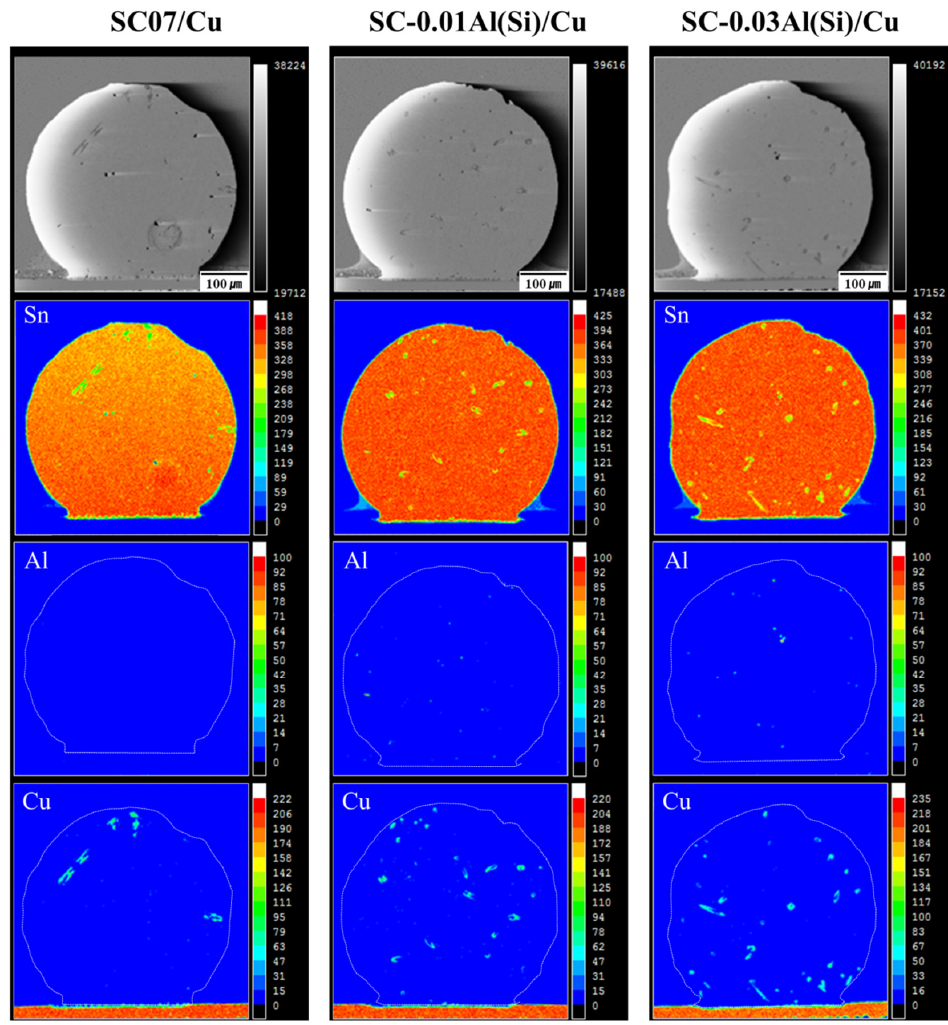
Figure 10. EPMA electron mapping of various solder joints after 10 reflows [27]. Thermodynamic calculations and experiments have shown that the ternary Sn-Al- Cu system has a large stable liquid miscibility gap [36,37], through which Al-Cu IMCs should traverse through Al-added solder alloys during soldering. According to a report by Kotadia et al., when Al was added to the SAC305 solder, Al 2 Cu IMCs were observed after the reflow [38]. Figure 11 shows the TEM image of the SC-0.03Al(Si) solder and the selected area electron diffraction (SAED) patterns after 10 reflows. In Figure 11b,c, Al-Cu IMCs and Cu-Al-Sn IMCs were observed. The SAED patterns are consistent with the re- ported crystal structures of Al 2 Cu IMCs and Cu 3 (Al 0.75 Sn 0.25 ) IMCs [35,38].